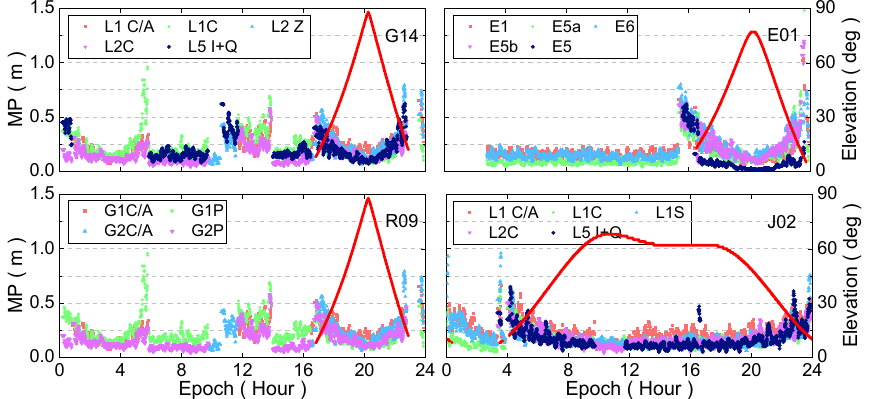
Figure 4. The MP series of GPS/QZSS/GLONASS/Galileo for DOY 283 on JFNG station. (The red wave indicates the sequence of elevation angle).